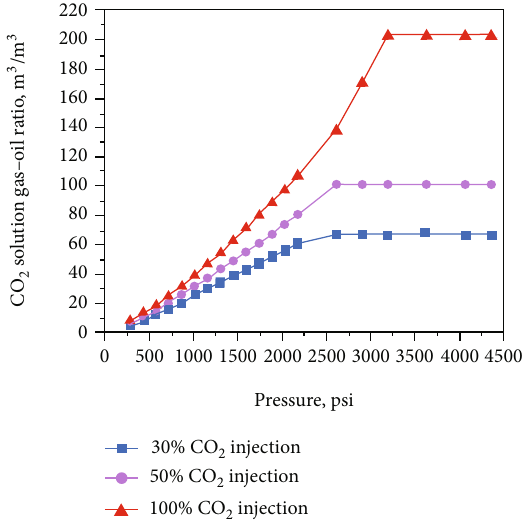
Figure 10: CO solution gas-oil ratio of the Bakken tight oil versus 2 injections at T = 230 ° F. pressure at various CO 2